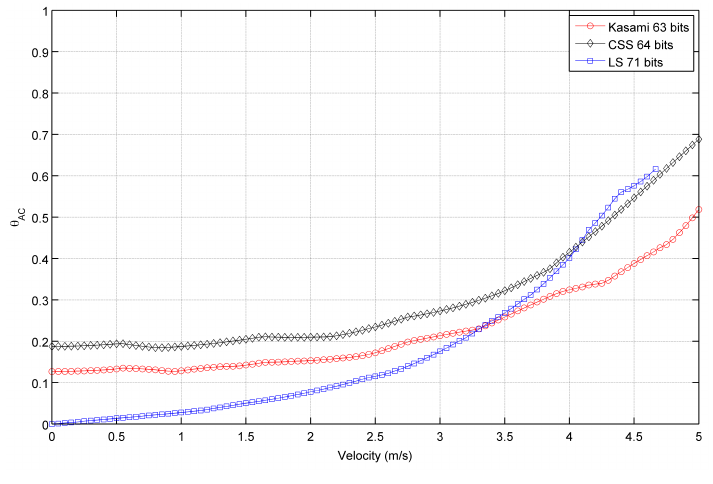
Figure 2. Simulated auto-correlation bound for the sequences with lengths close